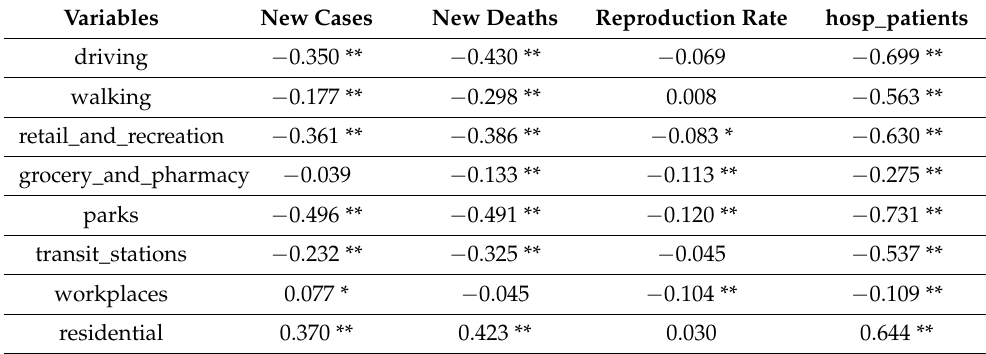
Table 7. Spearman’s r s correlation indexes calculated between variables indicating mobility and intensity of the disease in Poland.